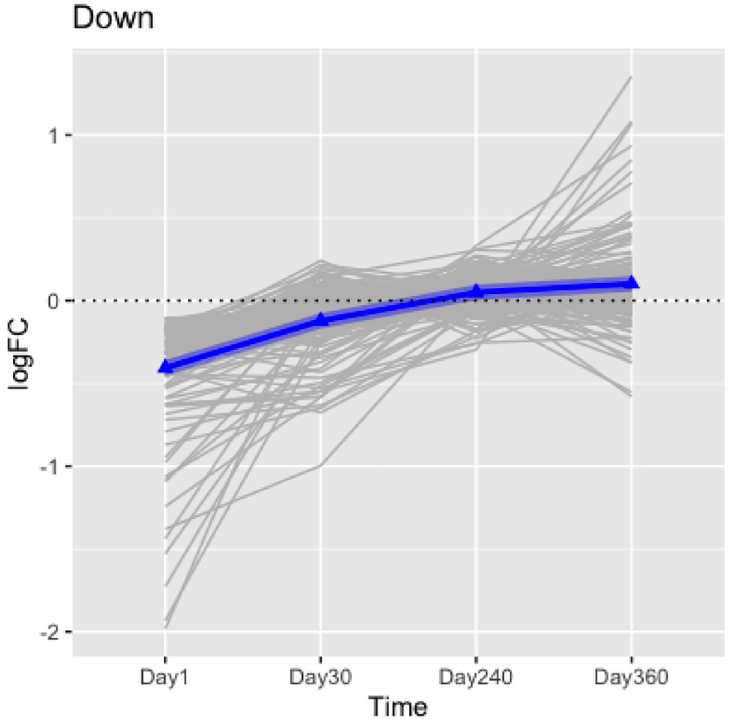
Fig 6. Trajectories of logFC of the DEG down-regulated with short-term effects (ISO vs. Na ï ve). The trajectory plot was generated using the logFC value between the ISO and na ï ve rats vs each post-exposure timepoint for each down- regulated gene. The 125 DEG (either down-regulated with p-value < 0.05 on Day 1 or consistently down-regulated with p-value < 0.1 at Days 1 and 30) were associated with wound healing and circadian rhythm pathways. The trajectories of the logFC for each gene were plotted as gray lines. The blue lines connecting the blue triangles are the mean trajectory. Groups of rats exposed to air (na ï ve, n = 6 /each timepoint group) or ISO (n = 5/Day 1 group, and n = 6/Day 30, 240, and 360 groups) were used.